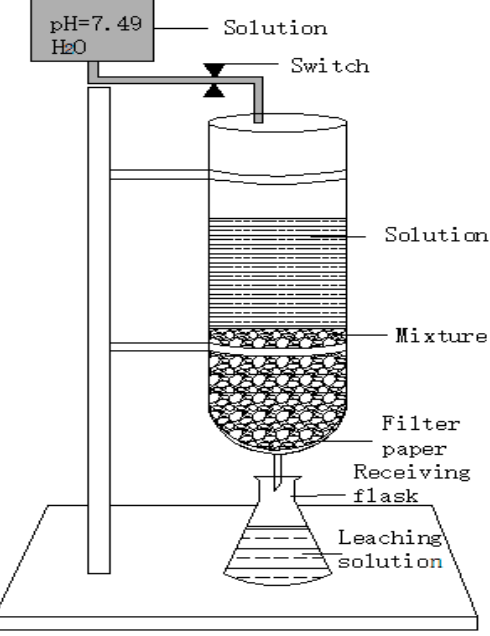
Figure 3. Column experiment setup.